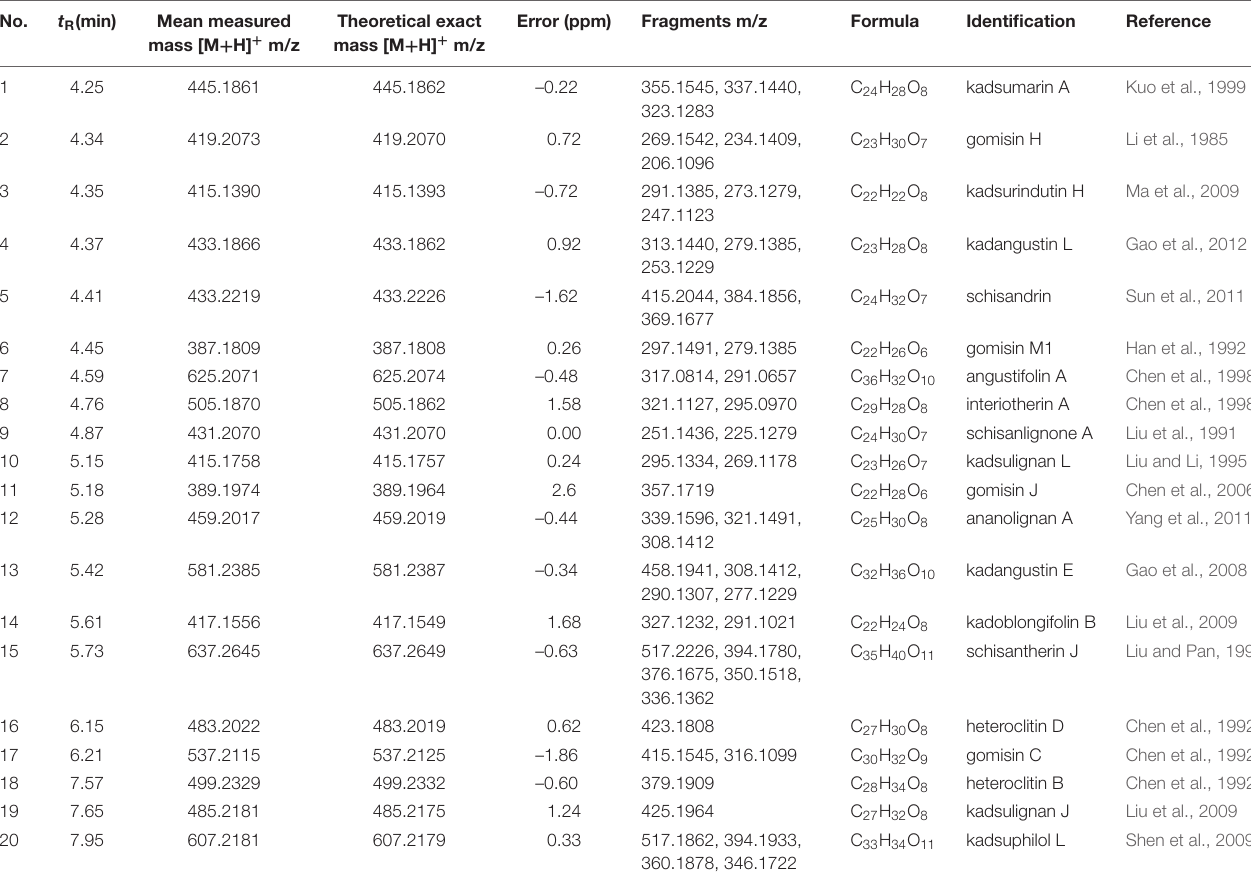
TABLE 3 | Tentatively identified compounds from K. longipedunculata , K. heteroclita , and K. coccinea .